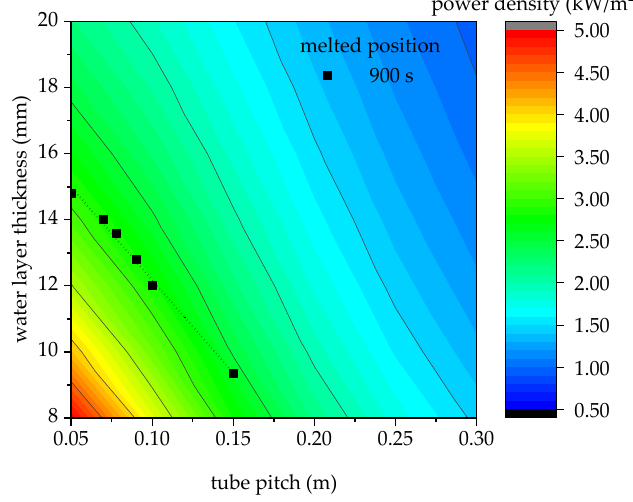
Figure 9. Heat exchange power density with tube pitch and water layer thickness.